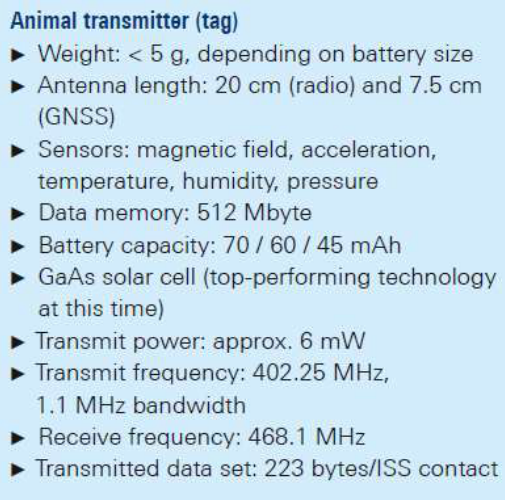
Table 5. ICARUS UL Link Budget.